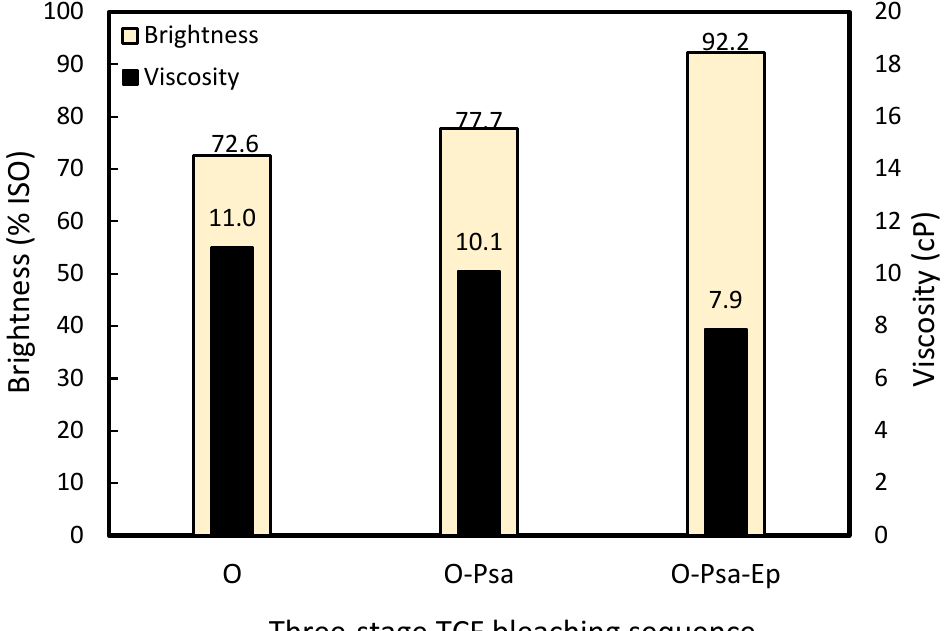
Figure 6. The brightness and viscosity profiles during three-stage totally chlorine-free bleaching of Nypa fruticans frond pulp at 20% AA dosage (O: oxygen; P sa : peroxymonosulfuric acid; E p : alkaline hydrogen peroxide).